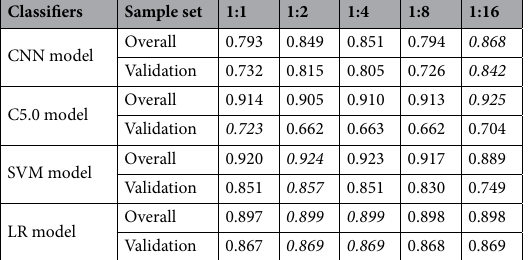
Table 7. The AUC for the four types of models. Significant values are in